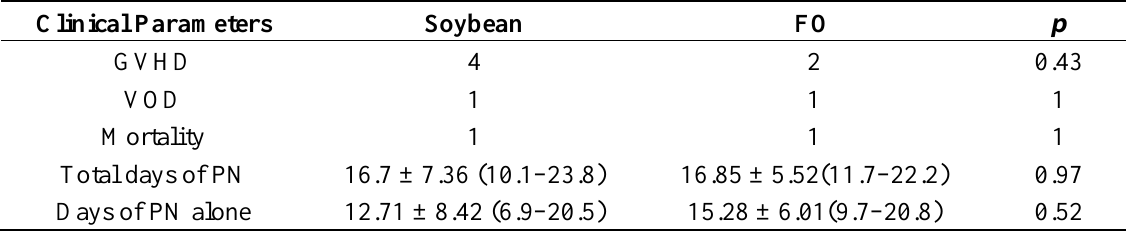
FO: fish oil-containing emulsion; GVHD: graft- versus -host disease; HSCT: hematopoietic stem cell